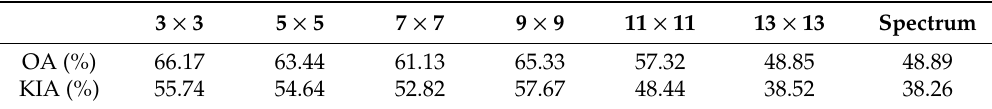
Table 8. The OA and KIA of urban vegetation types classification in